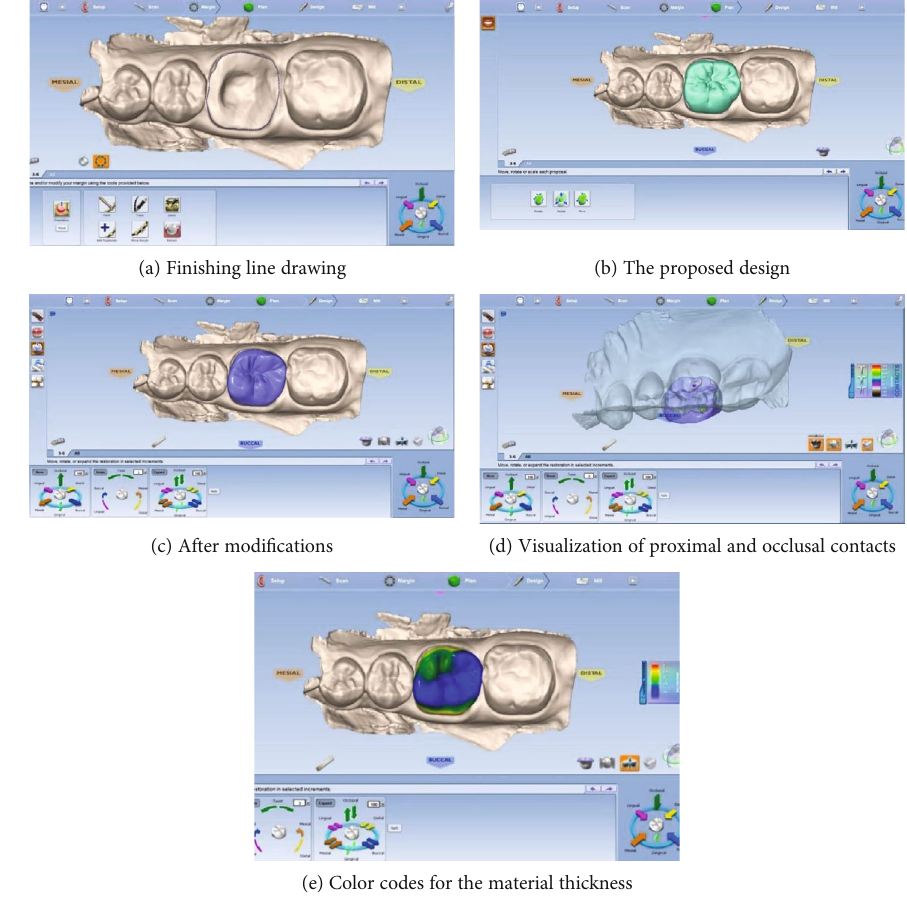
Figure 6: Design confection of the future